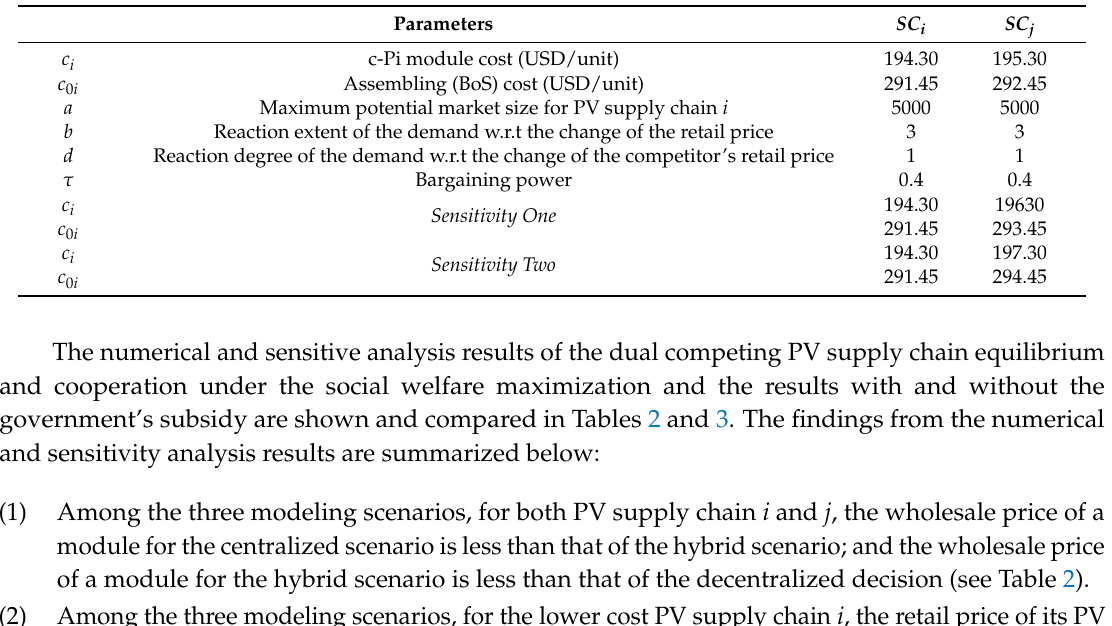
Table 1. Cost and demand parameters in the dual PV supply chains and for the sensitivity